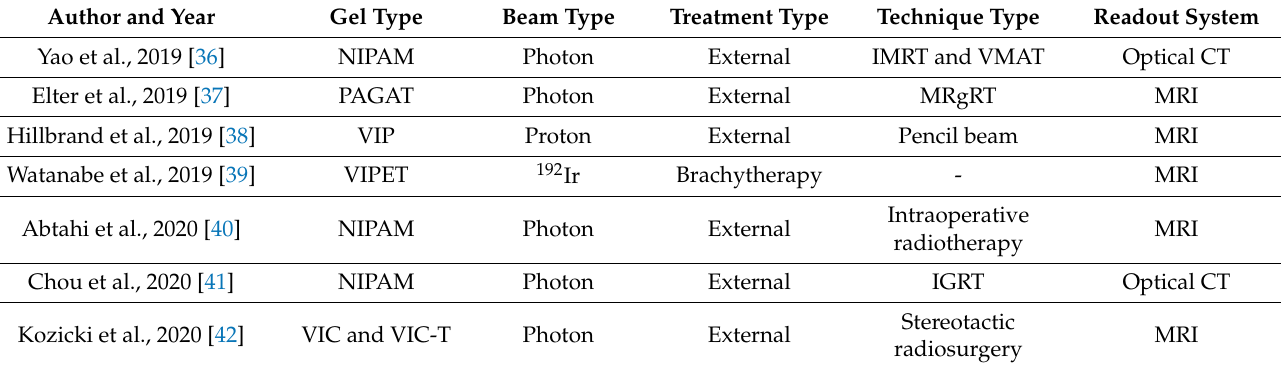
Table 1. Included clinical studies with polymer gel dosimetry published since